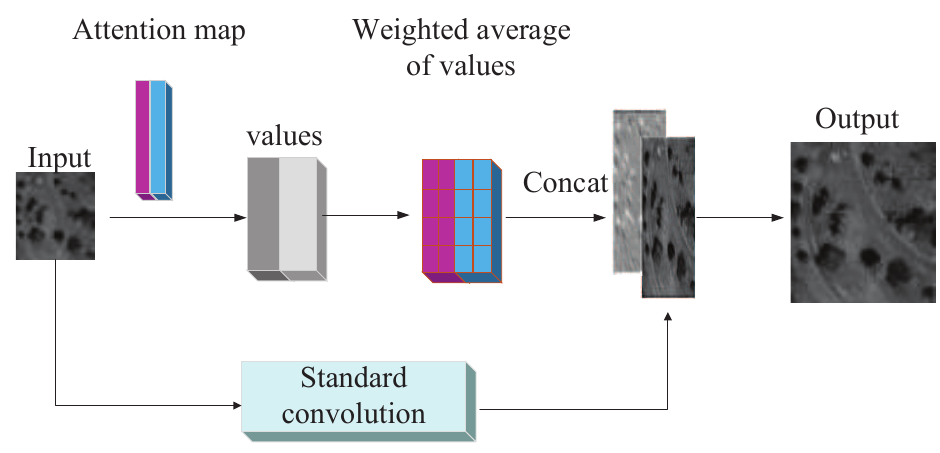
Figure 5. Attention-augmented convolution